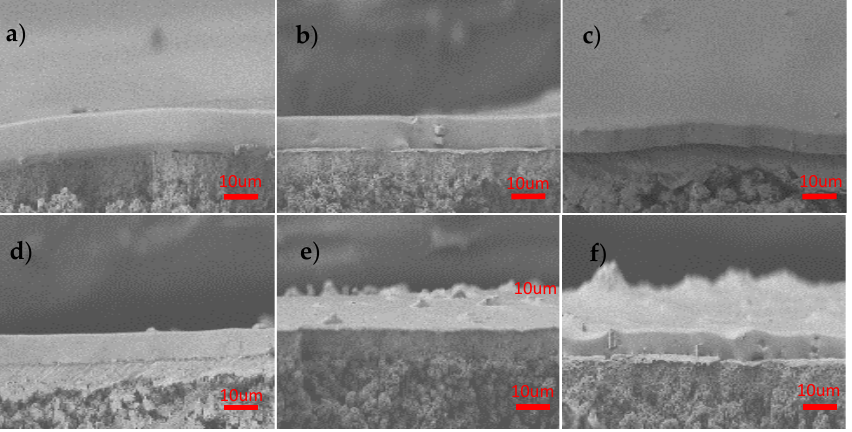
Figure 6. SEM image of cross-section of membranes. ( a ) M0; ( b ) M1; ( c ) M2; ( d ) M3; ( e ) M4; ( f ) M5. FT-IR spectra of the PMDS prepolymer and MMMs are shown in Figure 7a.